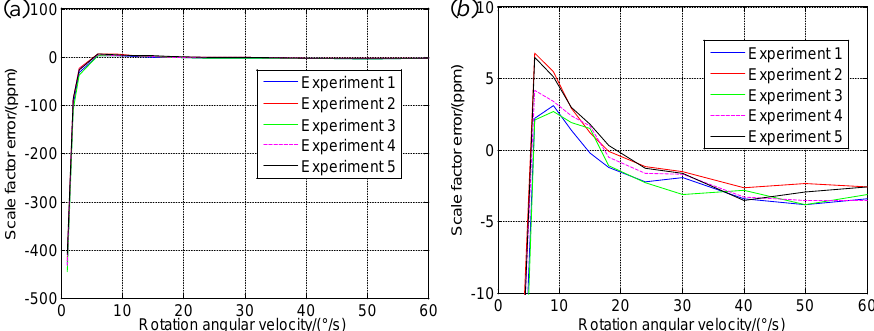
Figure 4. ∆ k b gz of the IMU in rate-biased mode; ( a ) ∆ k b gz with the change of the rotation angular velocity; ( b ) Partial enlargement of